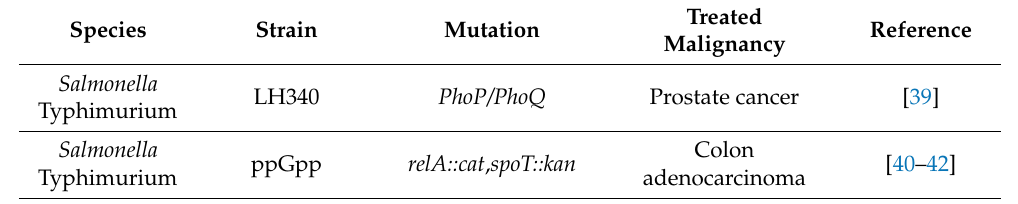
Table 1. Cont . Species